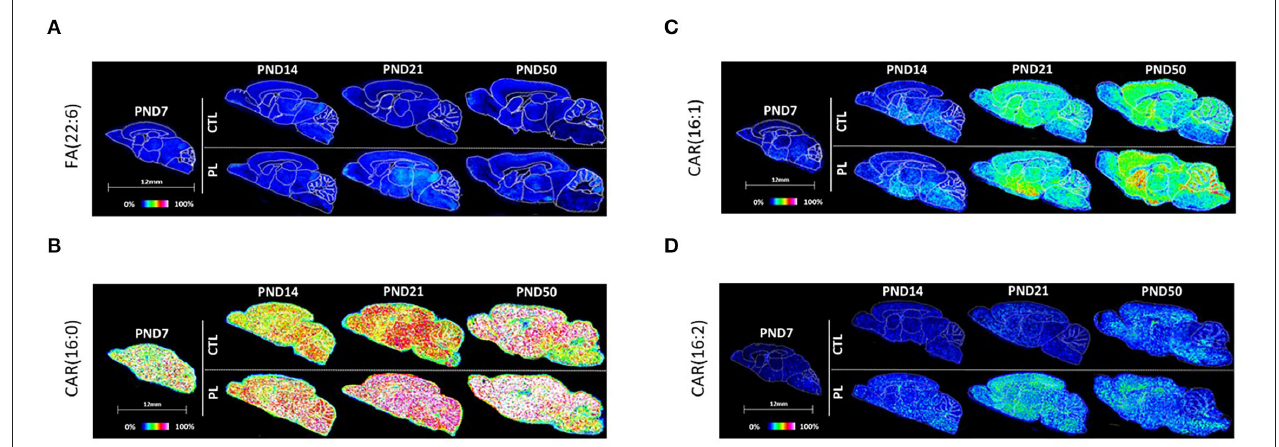
FIGURE 5 | Spatiotemporal distribution of fatty esters. Representative MALDI-MSI images are shown for (A) fatty acid FA(22:6) and (B–D) acylcarnitines CAR(16:0), CAR(16:1), and CAR(16:2). Control sections are presented on the top. PL-supplemented sections are presented on the bottom. The age is indicated above the images. The signal intensity scale is normalized to 100% of maximum peak intensity across all